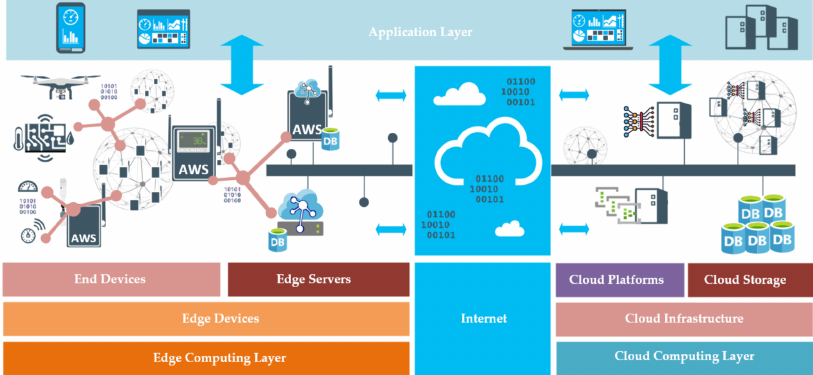
Figure 2. Automatic Weather Stations in an Edged Internet of Things (IoT) system